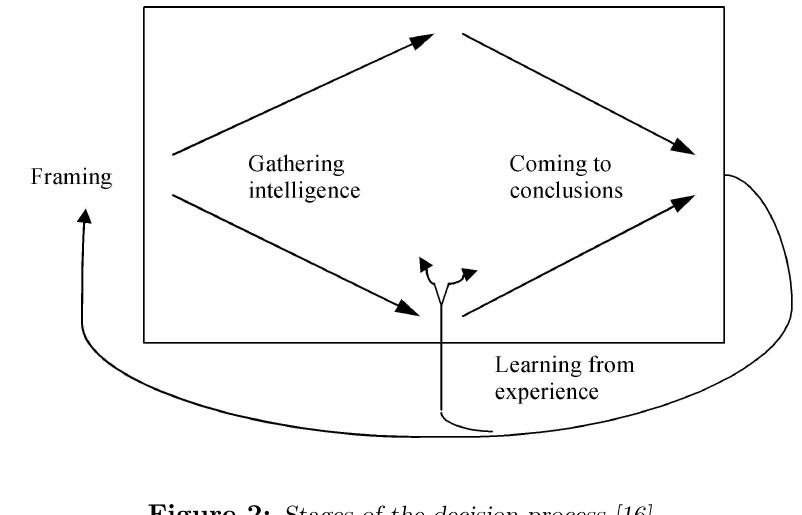
Figure 2: Stages of the decision process